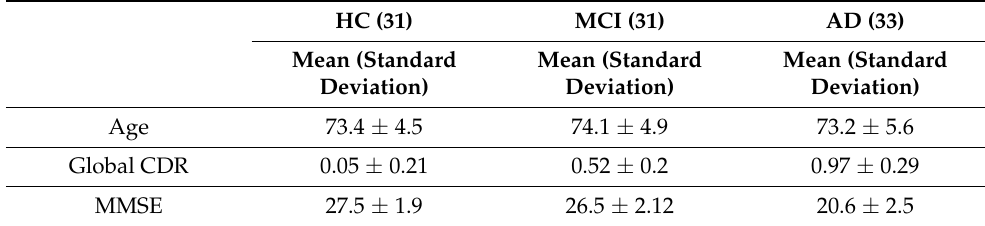
Table 1. Demographic data of the subject